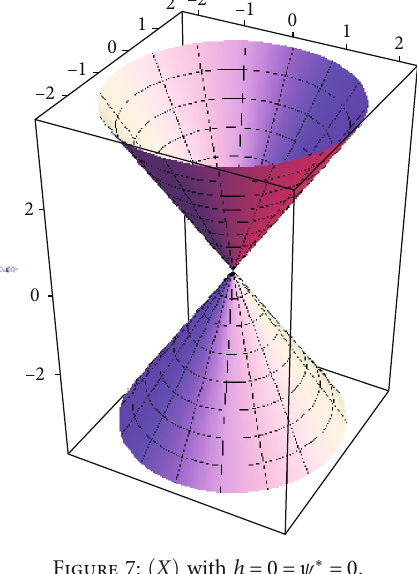
Figure 7: ð X Þ with h = 0 = ψ ∗ = 0